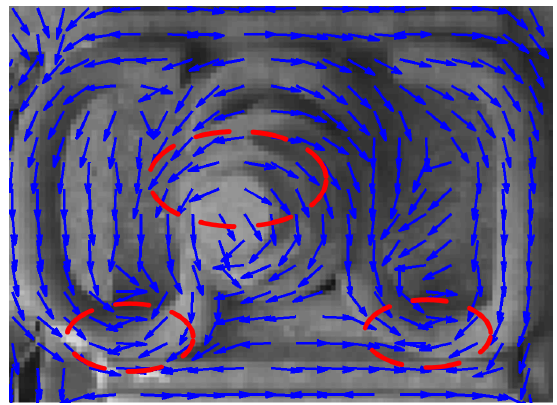
Figure 5. Direction Field